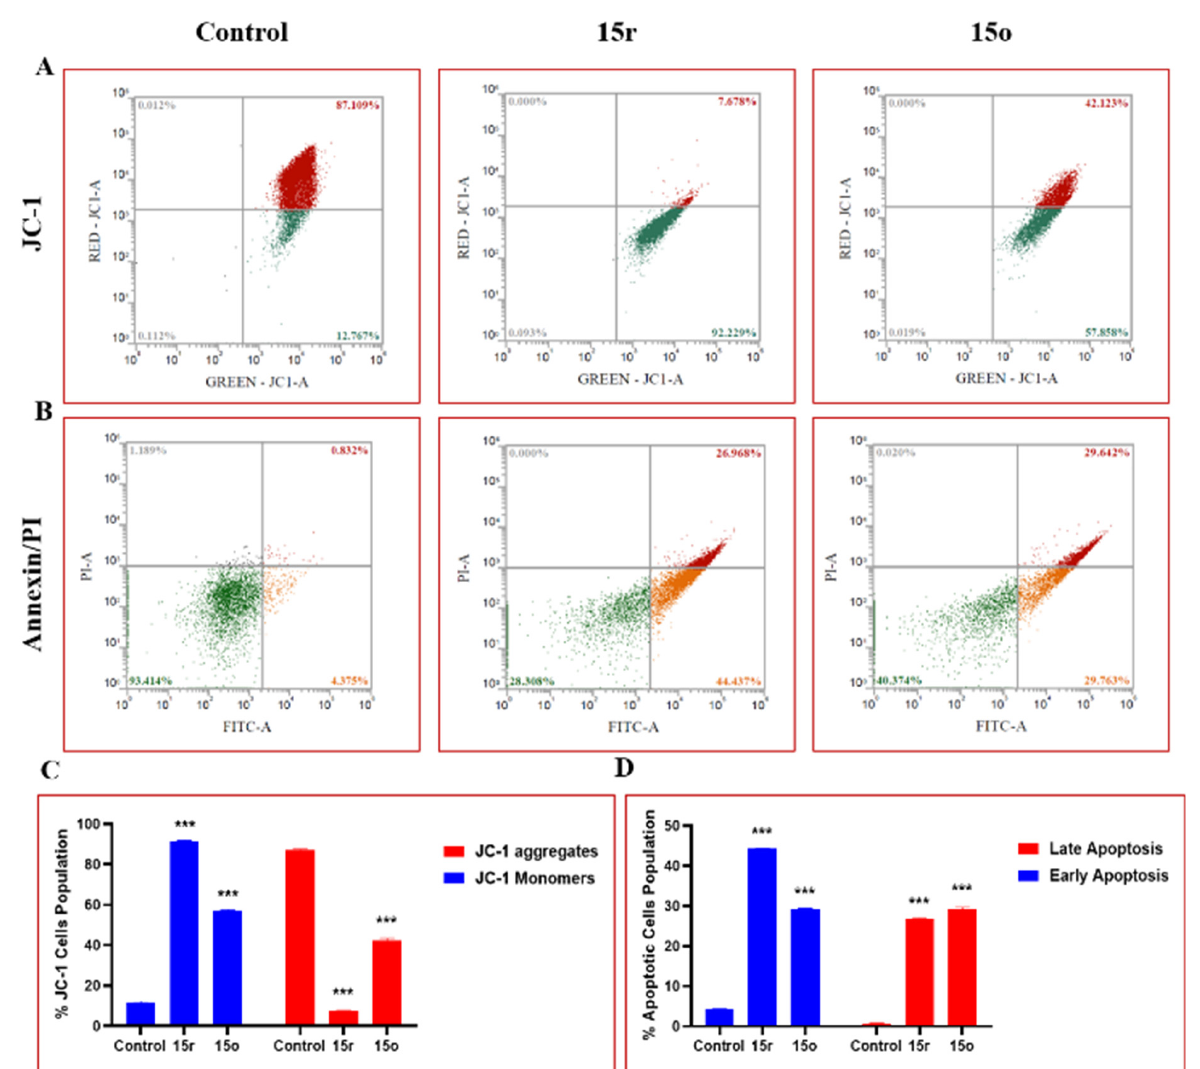
Figure 5. ( A ) Treatment with 15o (2 µ M) and 15r (1 µ M) in HT-29 cells caused the increased formation of JC-1 aggregates when compared to control cells, while a significant reduction in the levels of JC-1 monomers was found in the treated groups. ( B ) Compounds 15o (2 µ M) and 15r (1 µ M) induced apoptosis in HT-29 colon cancer cells. Flow cytometry graphs depicting early apoptosis, late apoptosis, and necrotic population of HT-29 cells. ( C ) Flow cytometry bar graph depicting the% JC-1 cell population of HT-29 cells. ( D ) Bar graphs representing early and late apoptotic cell populations in HT-29 cells observed after Annexin/PI staining. Statistical significance was determined by two-way ANOVA followed by Tukey’s post hoc analysis, where *** p < 0.001 represents control vs.